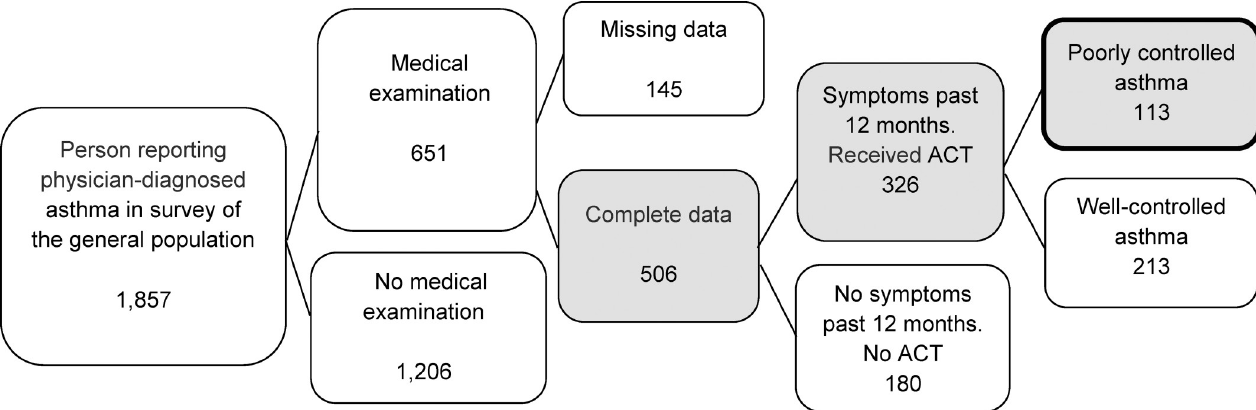
Fig 1. Inclusion of participants reporting symptoms during the past 12 months (n = 326), and those with poorly controlled asthma (n = 113). ACT; Asthma control Test.